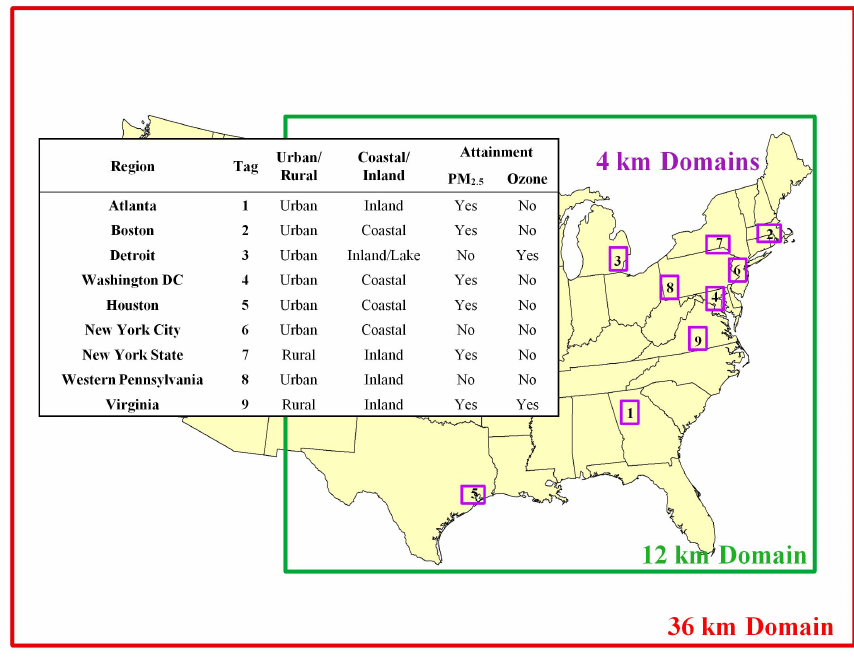
Fig. 1. Modeling domain: the extent of the 36km domain is shown in red, the 12km domain in green, and nine 4km domains in purple. The results reported for each of the three resolutions apply to the nine 4km sub-domains shown